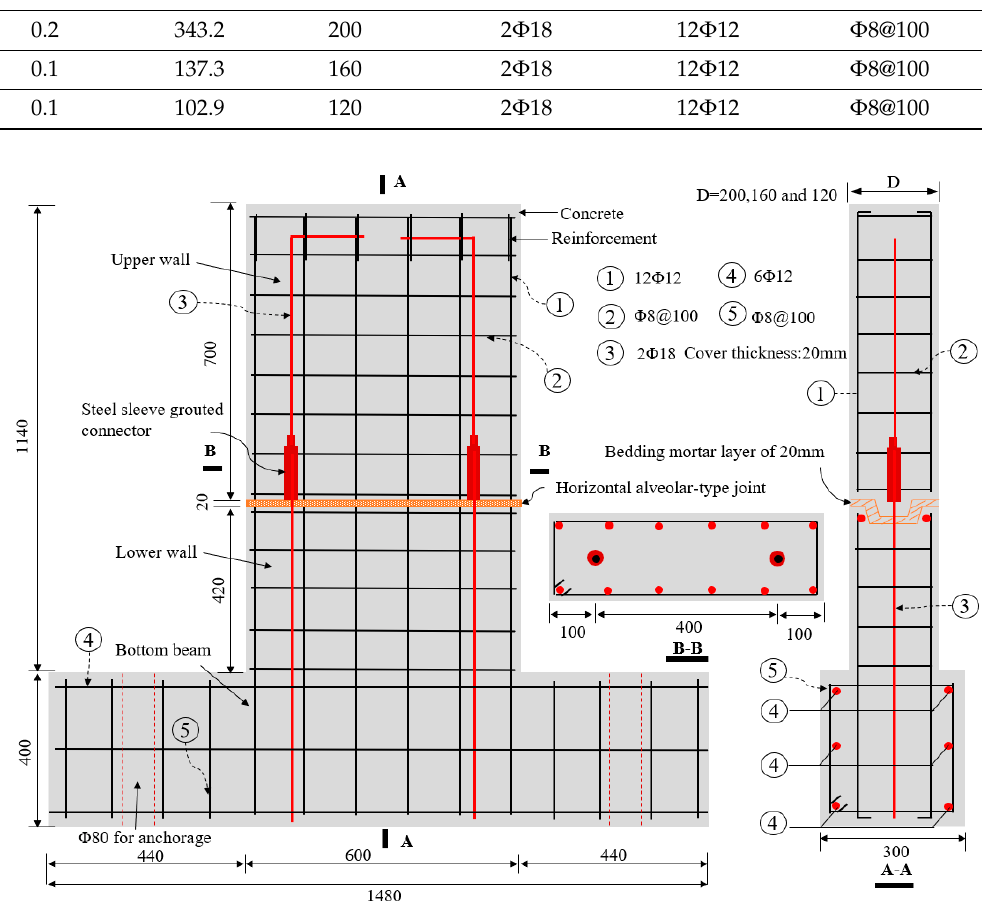
Figure 2. Geometric sizes and layout of reinforcing bars for specimens (in mm). Table 1. Main parameters of PW1–PW6.